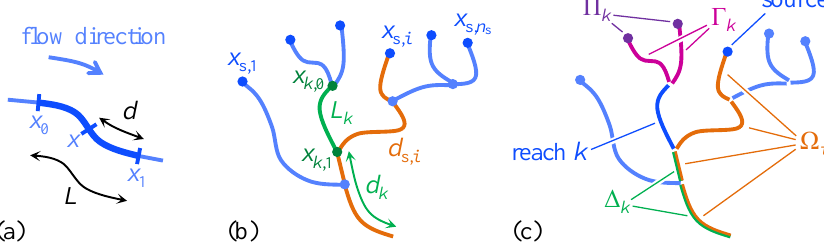
Figure A1. Schematic representations of (a) a stream reach and (b–c) a stream network, illustrating the notation used in Appendix A to derive the analytical solution to the stream energy